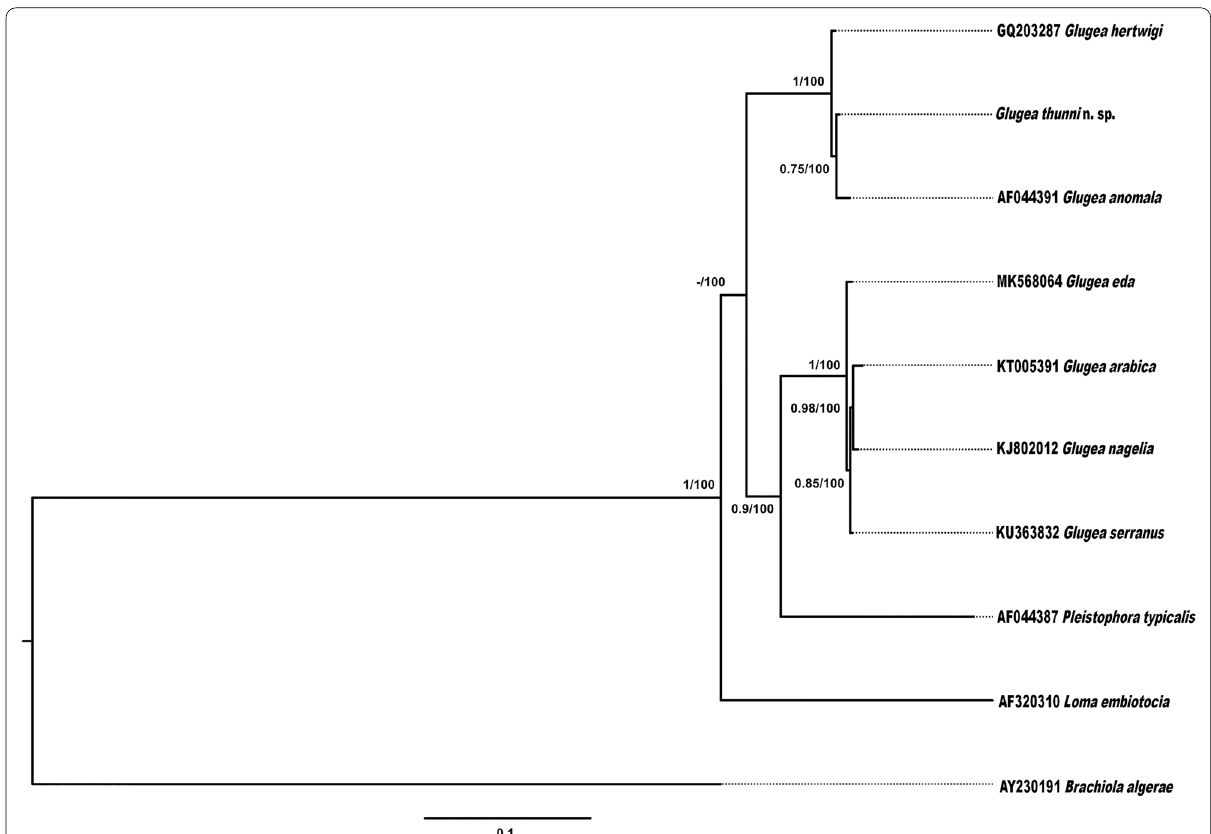
Fig. 6 Resulting tree for the analyses of the microsporidians based on partial 16S rDNA sequences (1713 bp). Nodal support is given as posterior probabilities (BI) and bootstrap values resulting from maximum likelihood (ML) analysis in the form (BI/ML); only values > 0.95 (BI) and 70% (ML) are shown. The scale‑bar indicates the expected number of substitutions per